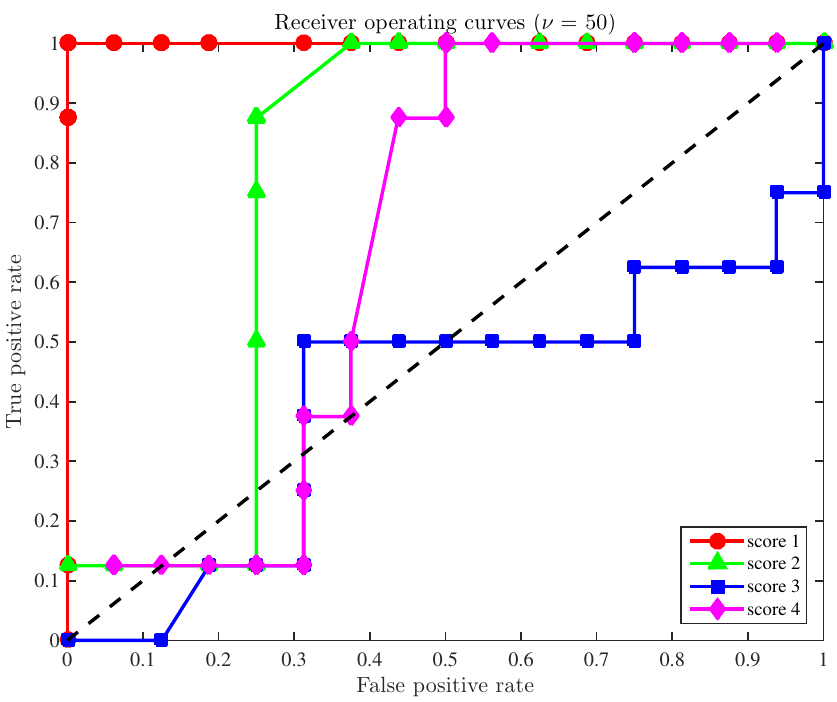
Figure 4. The ROCs for the four scores when the size of the samples to diagnose is ν = 50 and all the sensors are used.